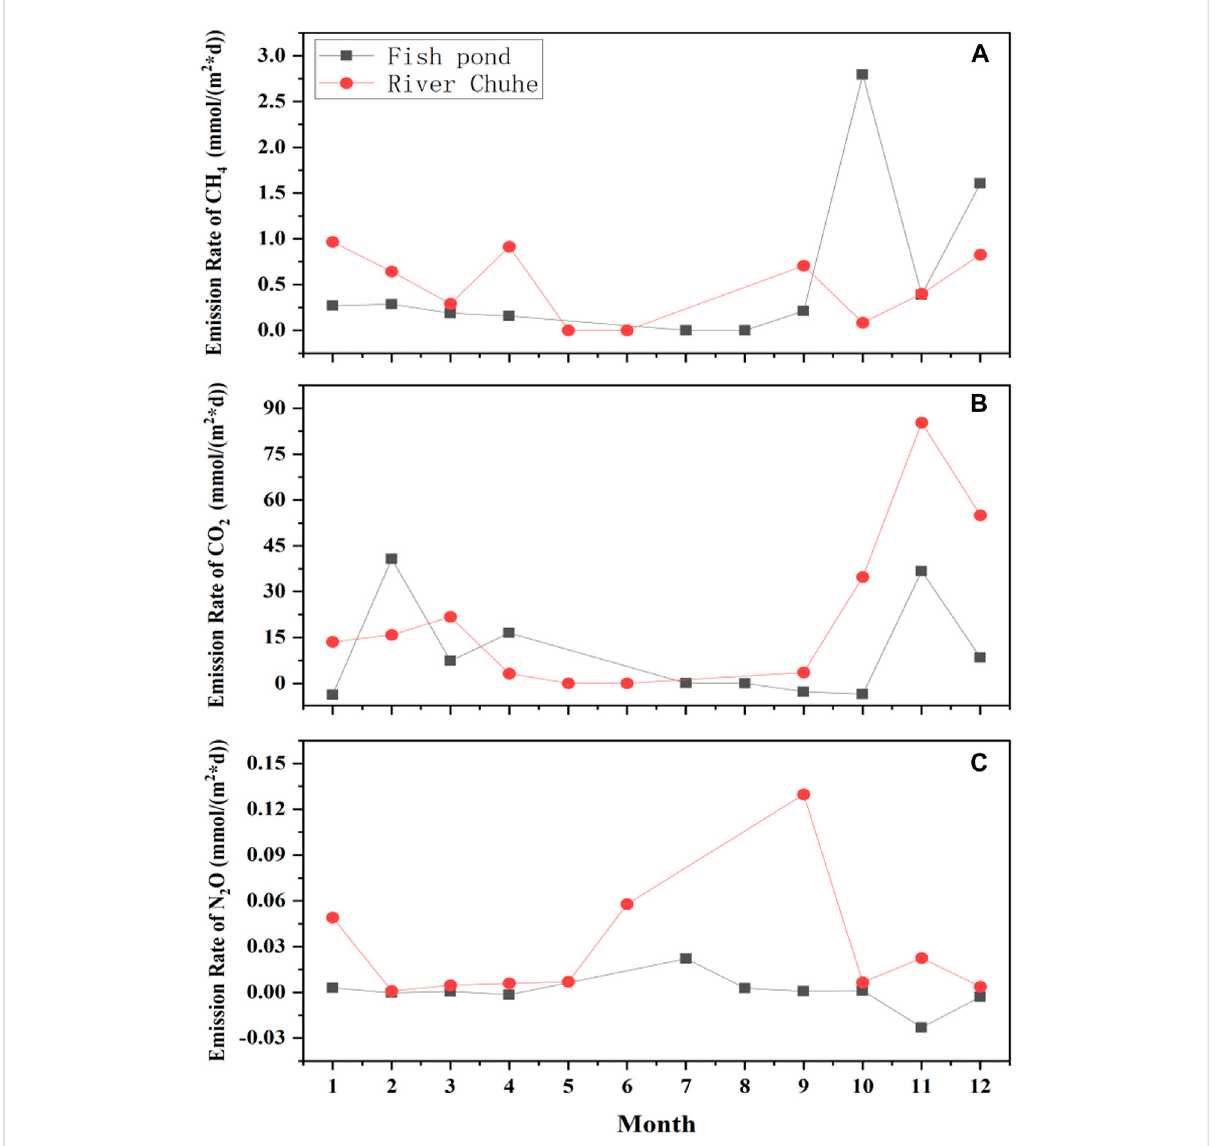
FIGURE 1 TemporalvariabilityinGHGemissionsrateduring fi eldobservation,where (A – C) denotestheemissionsrateofCH 4 ,CO 2 ,andN 2